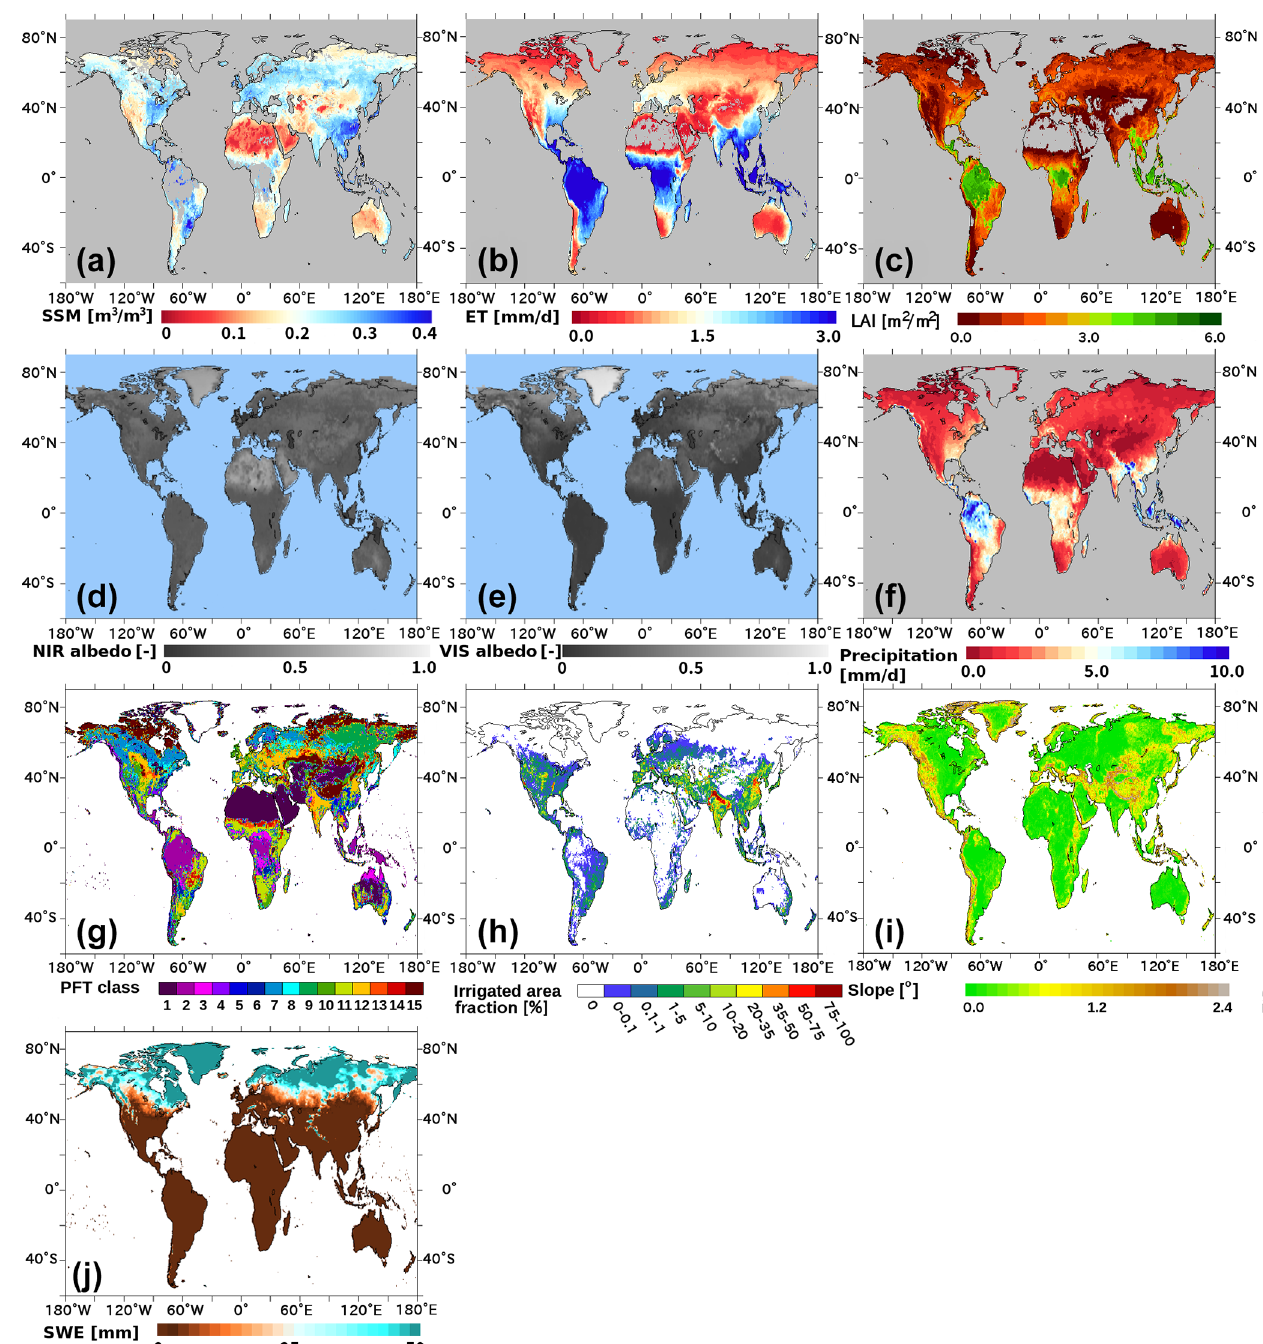
Figure 1. Spatial patterns of pluriannual mean reference data used for validation (marked with + ) and/or factor analysis (marked with × ). ( a + ) SSM from ESA CCI. ( b +× ) ET product of Jung et al. (2019). ( c +× ) LAI3g. ( d + ) MODIS NIR albedo. ( e + ) MODIS visible albedo. ( f +× ) GPCC precipitation data. ( g × ) Dominant plant functional type used in ORCHIDEE (see Table 2 for the class definition). ( h × ) Fractional area equipped with irrigation. ( i × ) Slope derived from ETOPO5. ( j × ) Snow water equivalent derived from the forced-mode